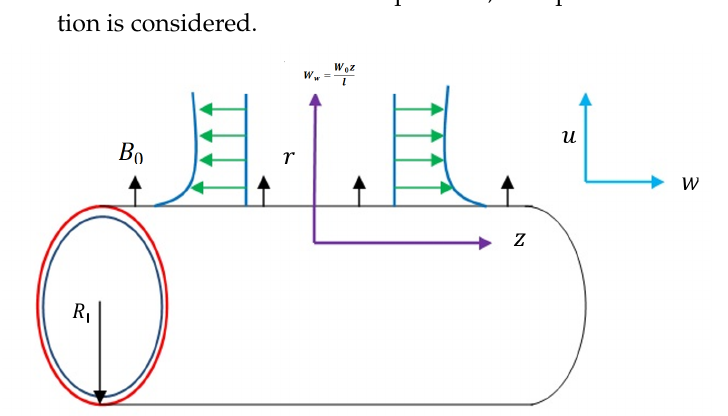
Figure 1. Physical